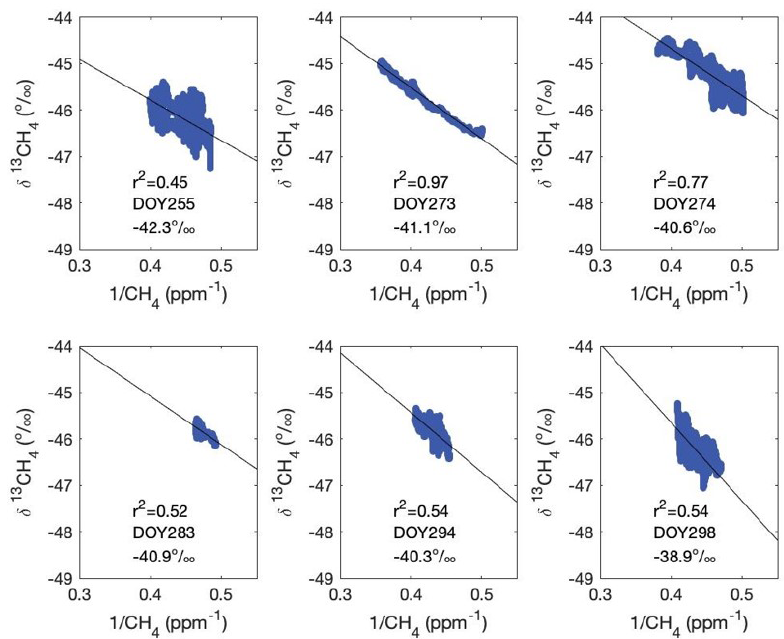
Figure 11. Keeling plots for six CH 4 peaks measured at the Maljamar tower, using 10min averaged data. Black lines indicate the best-fit lines. Correlation coefficients ( r 2 ), day of year (DOY), and y intercepts are indicated in the